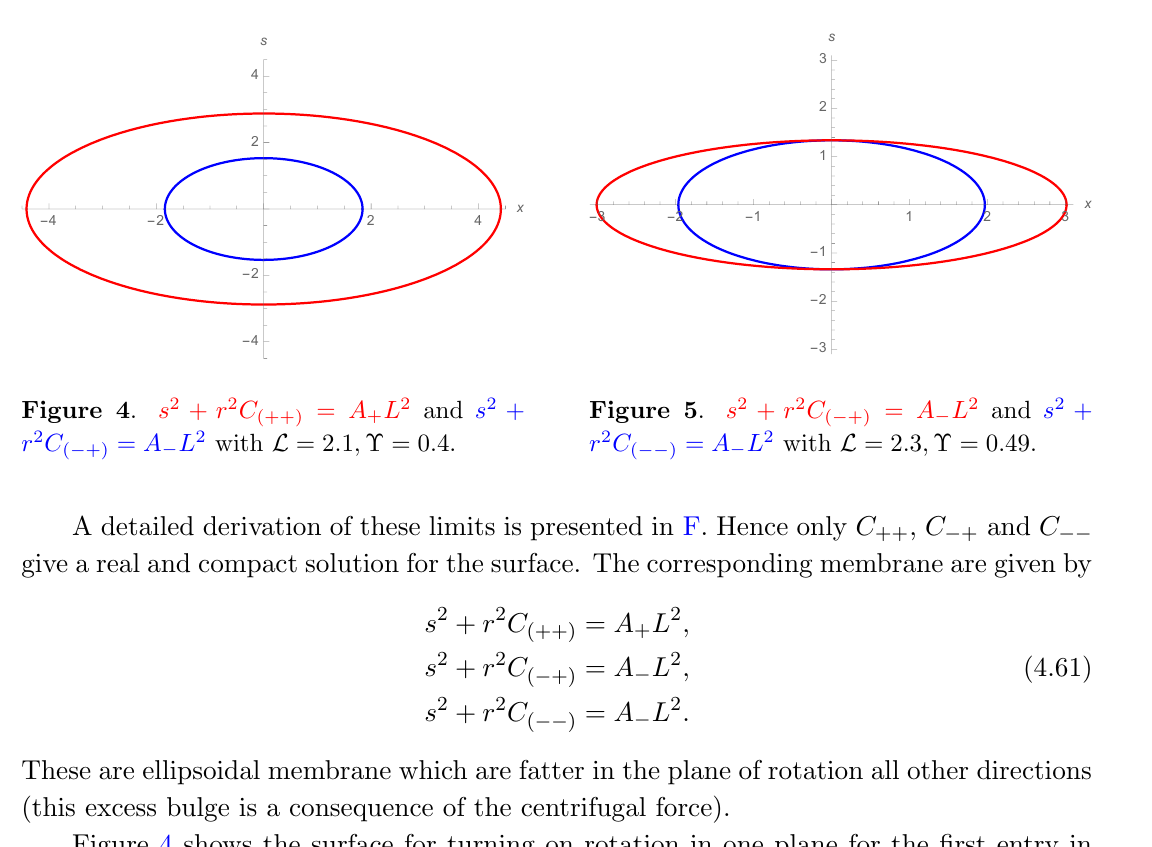
Table 1 . Allowed branches of solutions for di(cid:11)erent values of (cid:7).